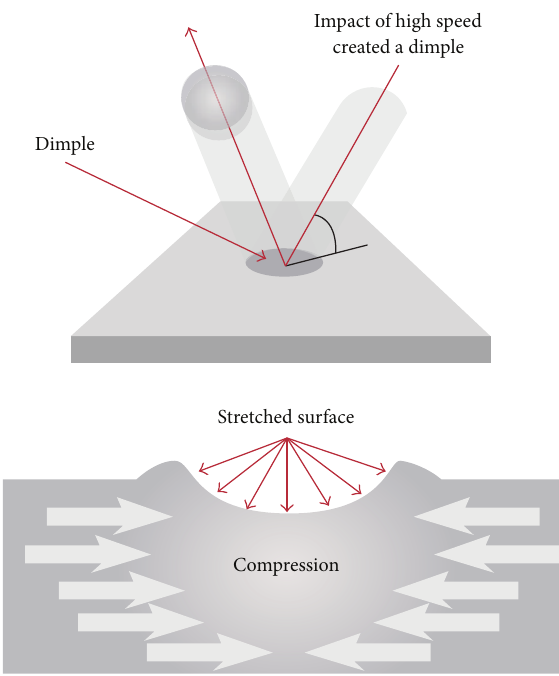
Figure 5: Schematic of shot peening bombardment on a surface with small high quality spherical media [5].